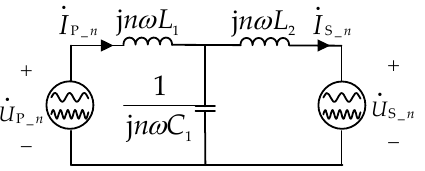
Figure 2. Equivalent model of the LCL-DAB converter. Taking forward power flow as an example, Figure 3 shows the main operating wave- forms with the DPS modulation scheme, which shows that the duty ratios of all gate signals are 50%. The inner phase shift time d 1 T is the phase shift time between S 1 and S 4 , or Q 1 and Q 4 , corresponding to the time interval of zero voltage time of u P and u S . The outer phase shift time dT is defined as the time difference between the symmetry axis of u P and u S , and its polarity determines the direction of power flow. Since the time origin setting does not affect the conclusion of the following analysis, the origin of the time axis is set to the midpoint of the positive level of u S for convenience of derivation. Therefore, the time-domain expressions of u P and u S